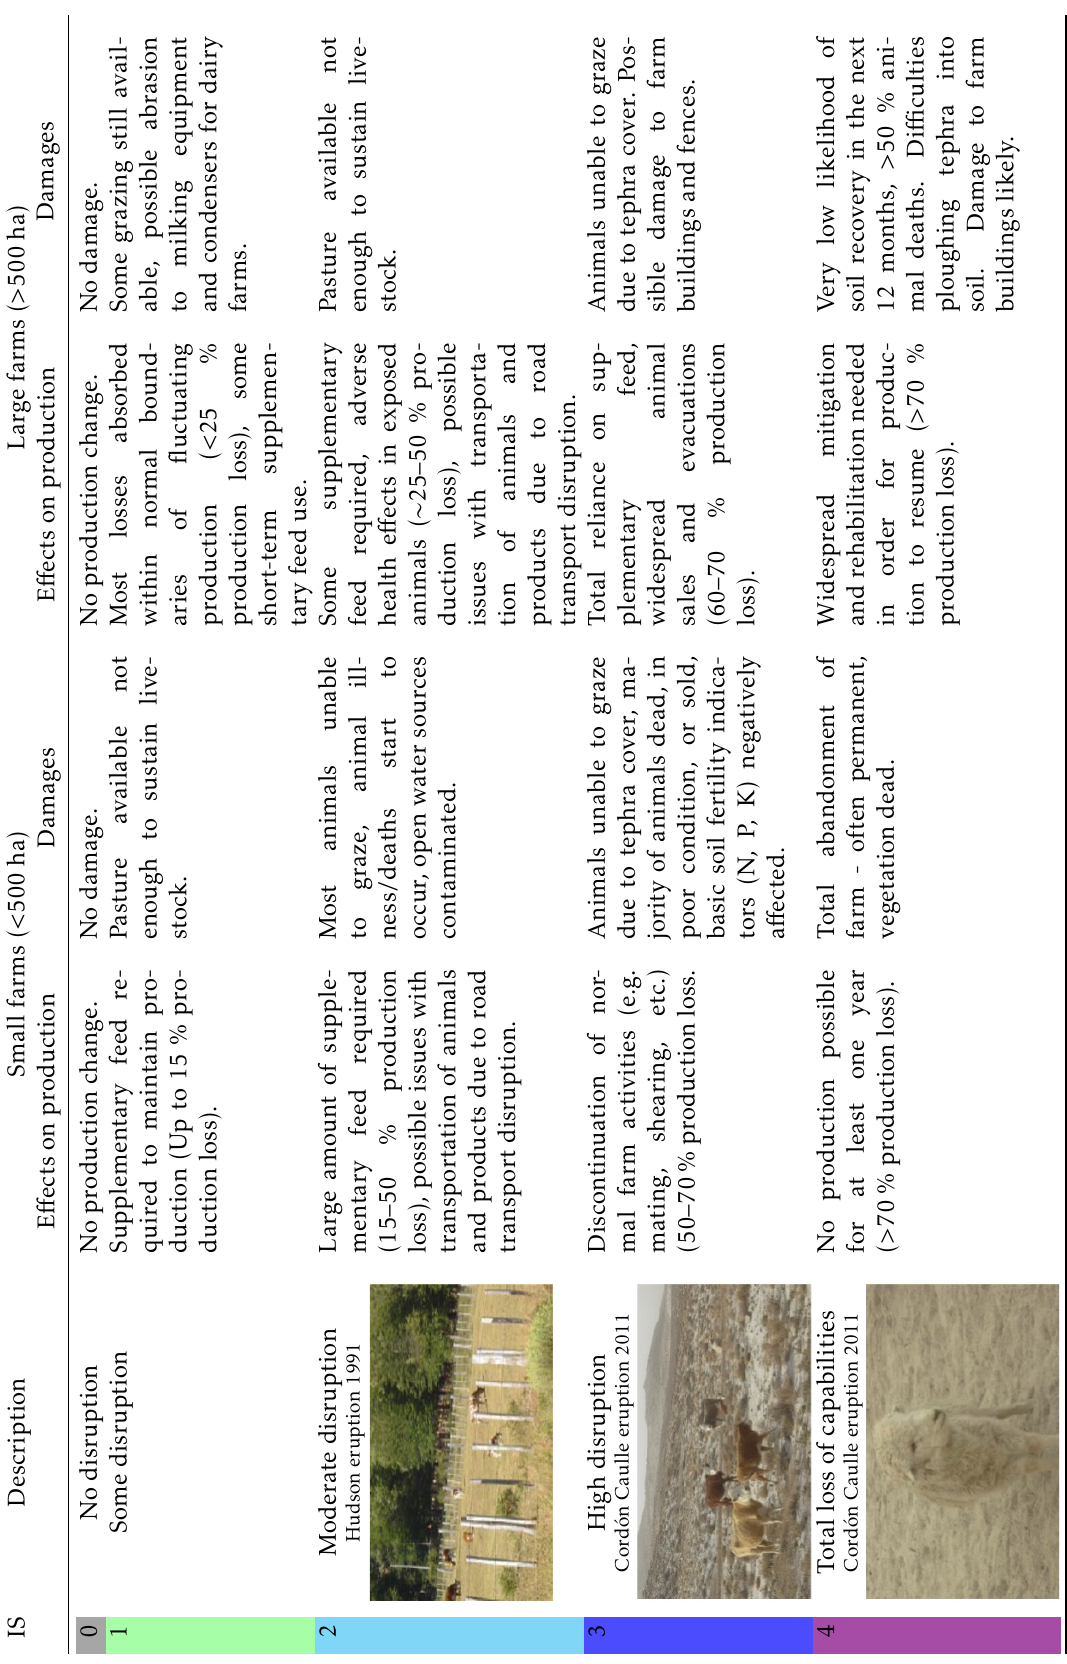
Table 4: Impact state (IS) scheme for small and large pastoral farms (including dairying) with example pho- tographs from post-event impact assessments. Photographs show farms impacted by previous eruptions that are representative of each